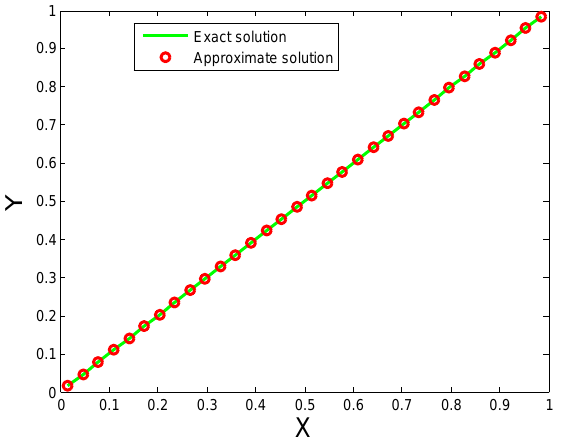
Figure 2. Comparison of exact α = 1 and approximate solution for N = 32 for Example